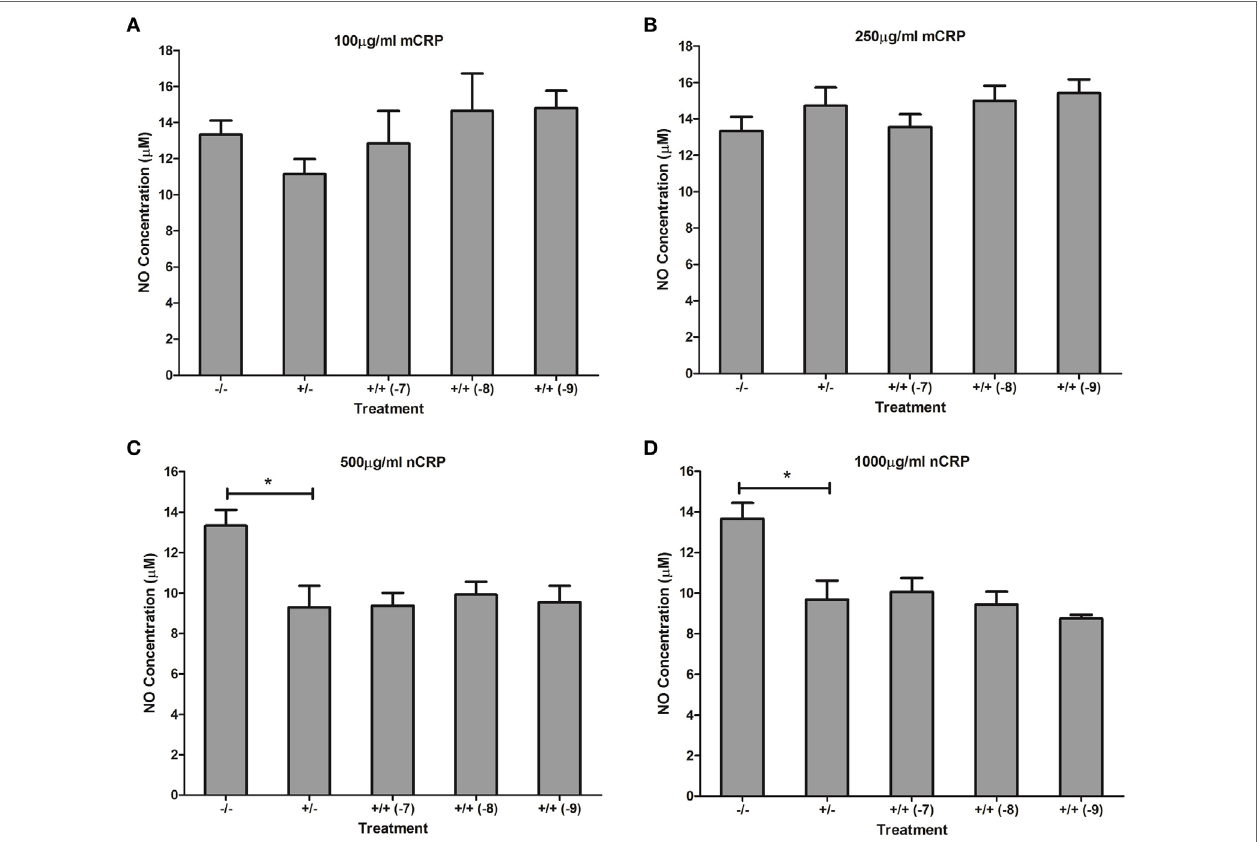
FigUre 10 | Effect of estrogen on CRP-mediated NO production by LPS-activated U937 macrophages. Estrogen had no effect on NO production when co-supplemented with mCRP (a,B) or nCRP (c,D) in activated U937 macrophages. − / − represents the negative control with no CRP or estrogen supplementation. + / − represents treatment with CRP alone. + / + represents treatment with both CRP and estrogen. The number in parentheses indicates the concentration (1 x 10 − 7 , 1 x 10 − 8 , or 1 x 10 − 9 M) of estrogen. * denotes a significant ( P < 0.05) reduction in NO production following treatment with nCRP compared to the control ( n = 12). Errors bars represent the